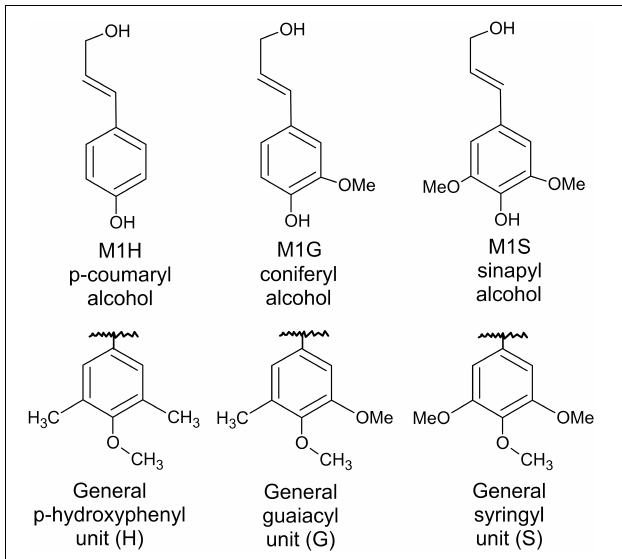
FIGURE 5 | Lignin alcohol precursors and resulting